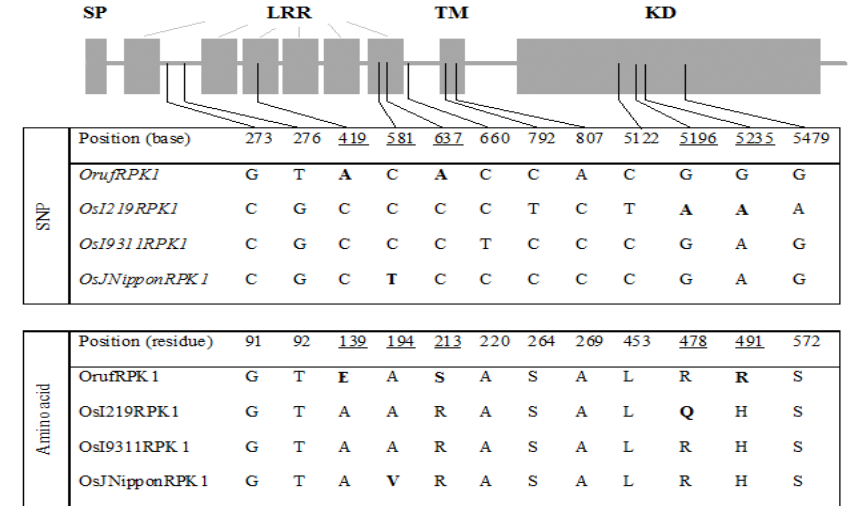
Figure 2. Structure of RPK1 and comparison of SNPs among four rice lines. Positions of the five substituted amino acids within the RPK1 locus are underlined and the corresponding SNPs and amino acids are in bold text. SP, signal peptide; LRR, leucine-rich repeat; TM, transmembrane domain; KD, serine/threonine kinase